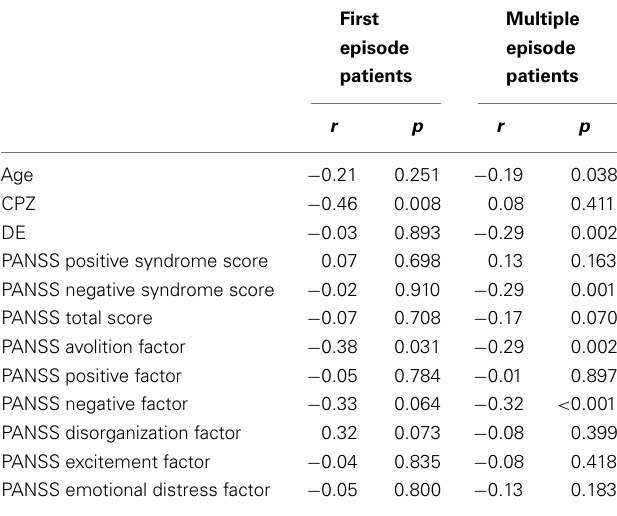
Table 2 | Correlation between activity level and clinical parameters